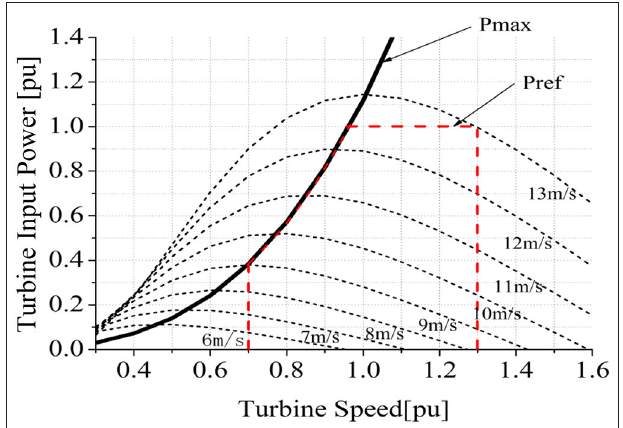
FIGURE 1 | The DFIG wind turbine